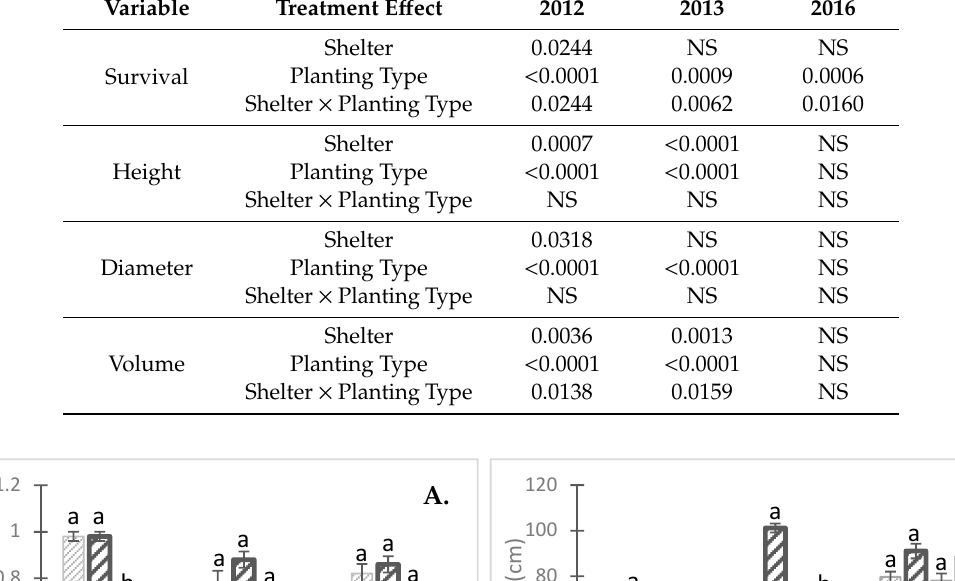
Table 1. P -values for the main treatment e ff ects and their e ff ect on measured response variables. P -values > 0.05 are indicated as nonsignificant (NS).